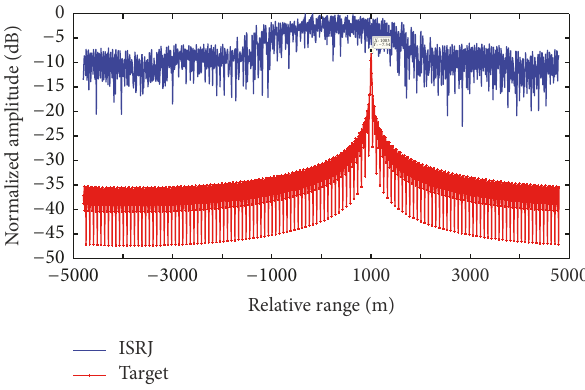
Figure 8: The compression result before ECCM ( 𝑇 𝑠 = 10𝜇𝑠